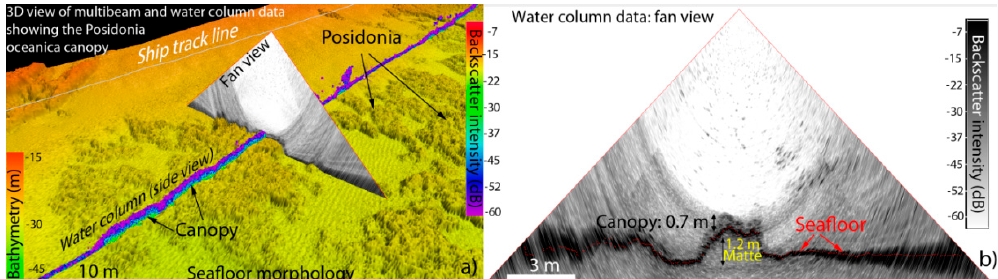
Figure 1. ( a ) Three-dimensional (3D) reconstruction of seafloor morphology and water column data from multibeam bathymetry (Multibeam Echo-Sounder (MBES)) for characterizing the matte and the canopy height of P. oceanica . ( b ) detail of acoustic fan view collected by multibeam showing the height of canopy and the matter of P. oceanica meadows on a sandy seafloor.